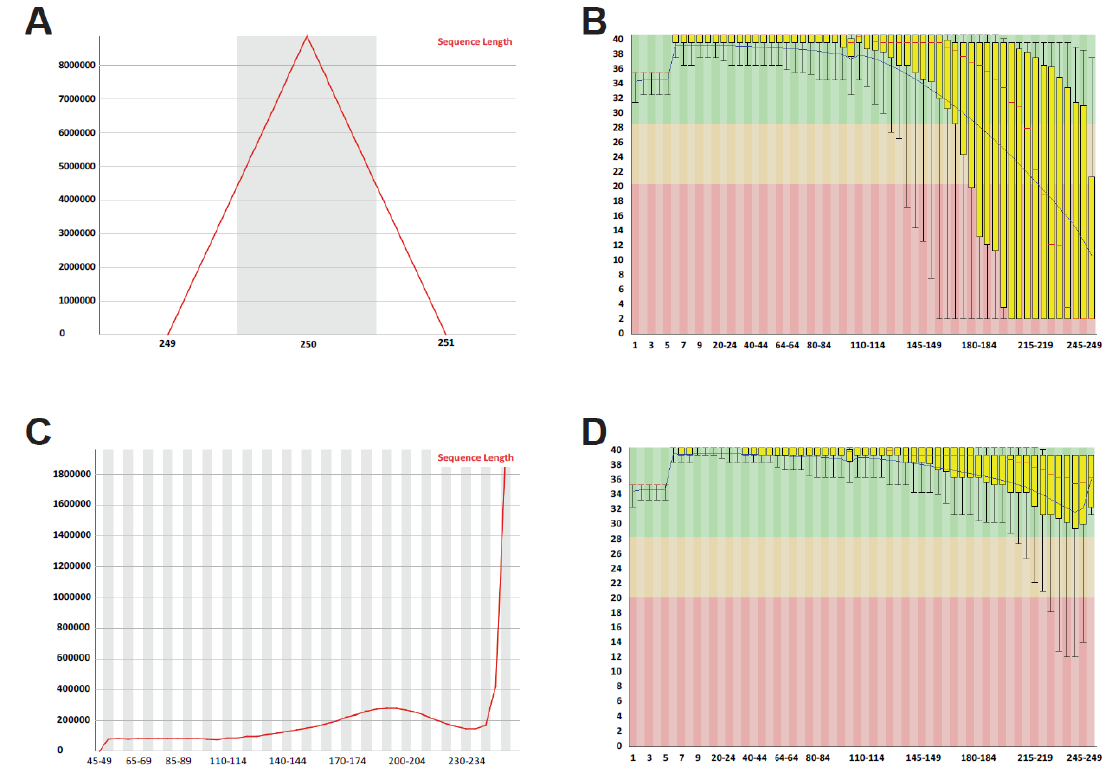
Figure A2. Metagenomics quality and length distribution: ( A , B ) before applying Cutadapt (Martin 2017): length distribution ( A ) and box plot distribution of quality score (Phred) ( B ). ( C , D )—length and Phred distribution after applying Cutadapt.